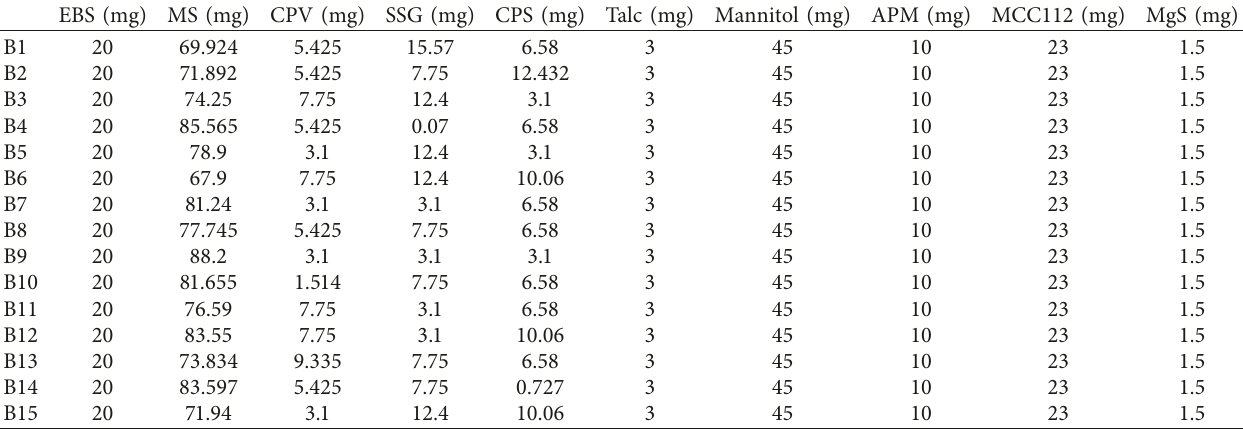
Table 1: Composition of various batches of fast disintegrating tablets of ebastine designed by Minitab software.